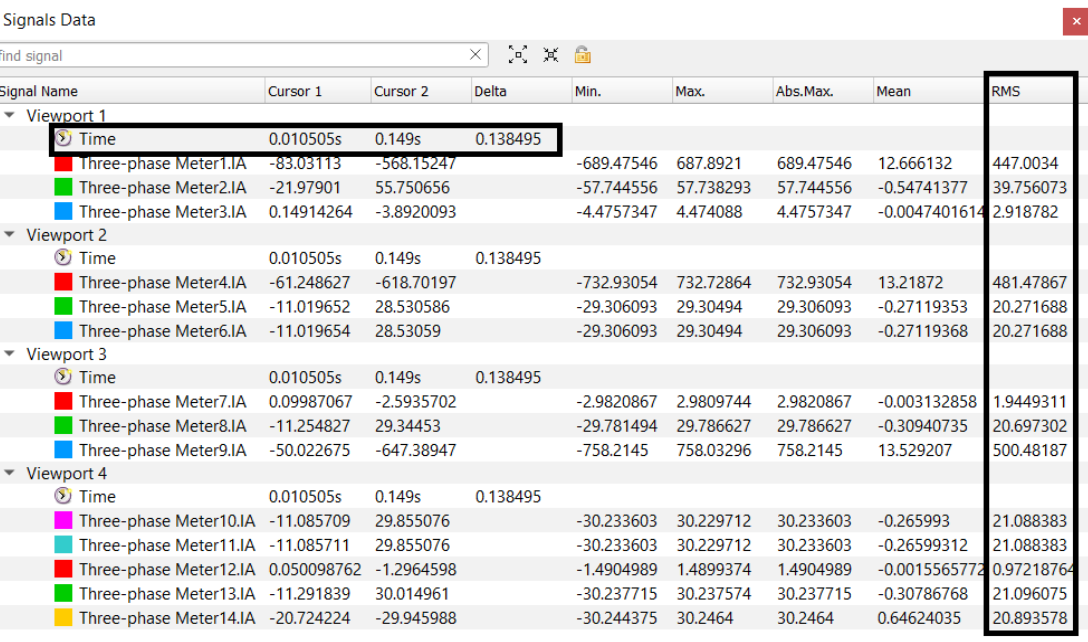
Figure 10. A 3LG fault at bus 9 in islanded mode.